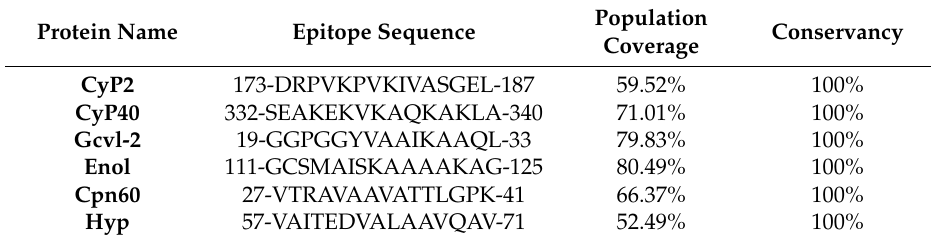
Table 2. Selected helper T lymphocyte (HTL) epitopes among L . infantum proteins to be a part of the multi-epitope vaccine.